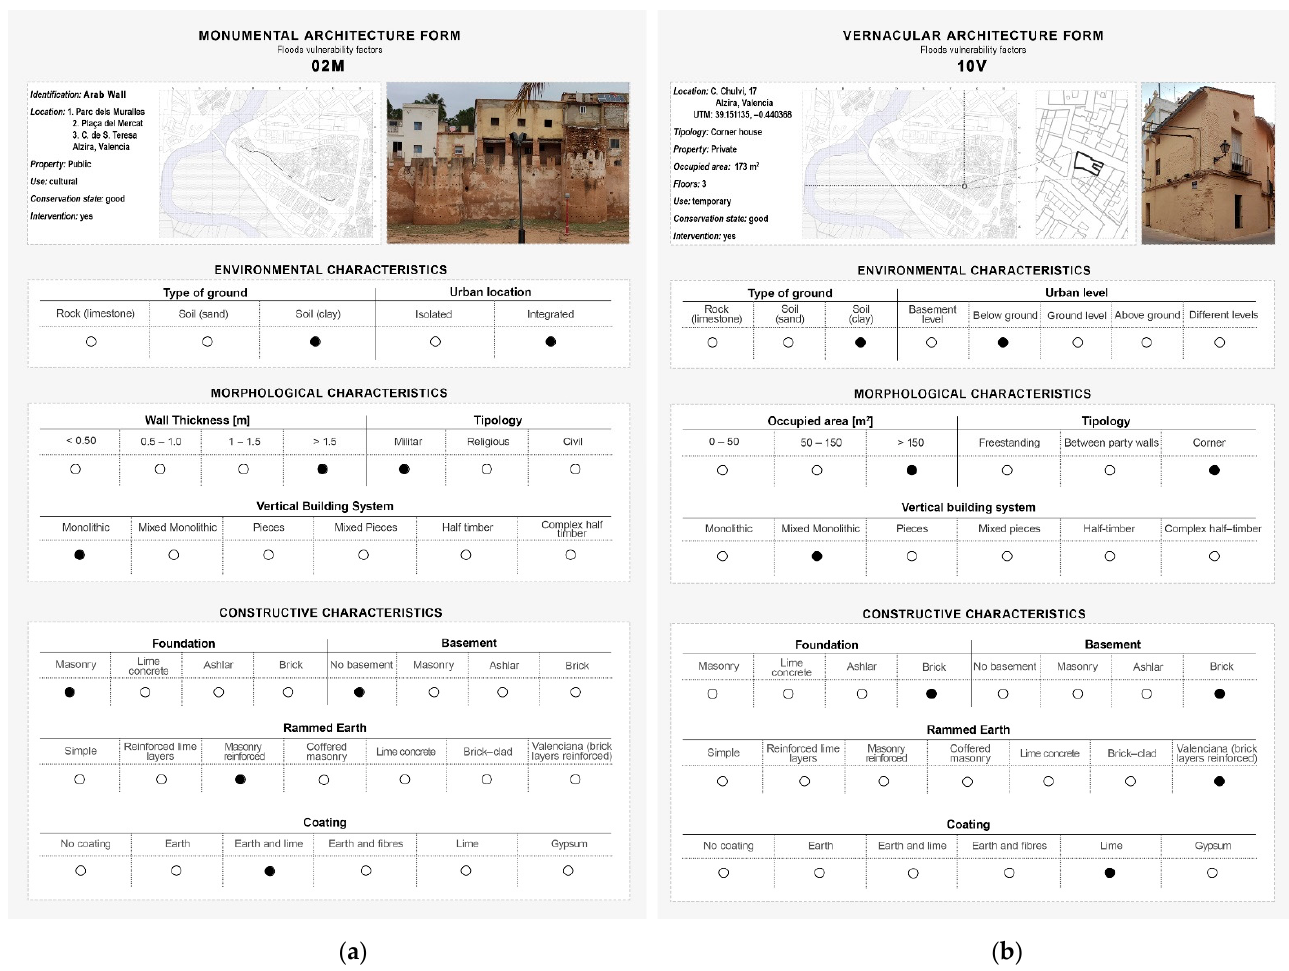
Figure 7. ( a ) Monumental architecture form. ( b ) Vernacular architecture form.